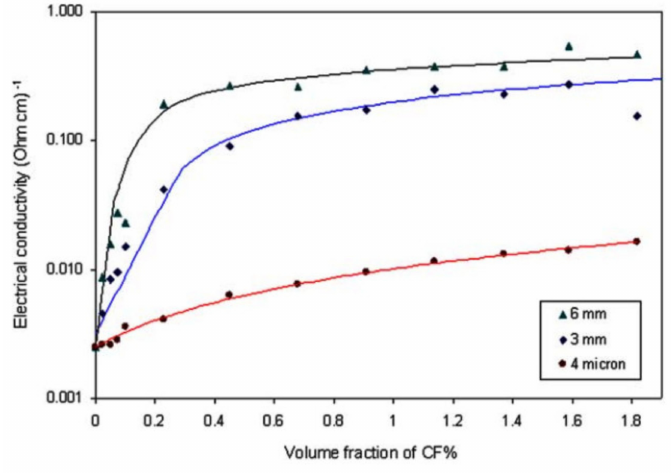
Figure 10. Impact of the fiber length on the sample in CFRC. Reproduced with permission from [39], Elsevier,